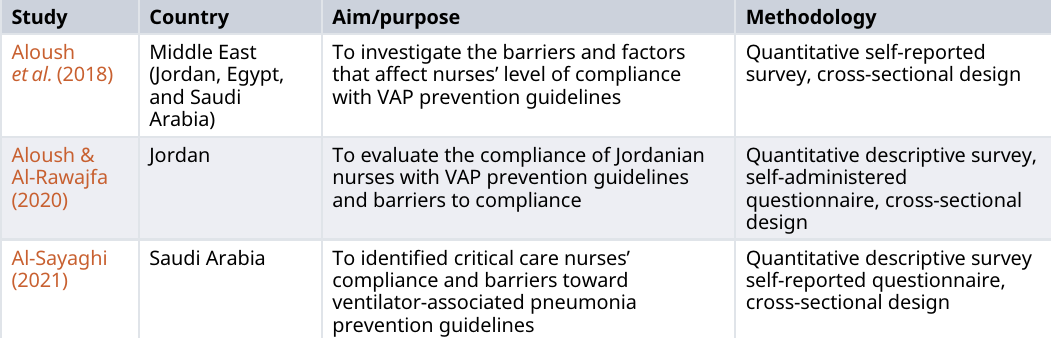
Table 3. Summary of general characteristics of